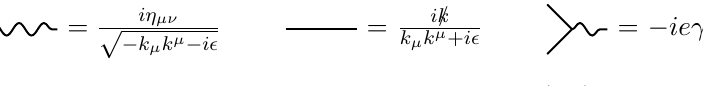
Figure 5 . Feynman rules for the action